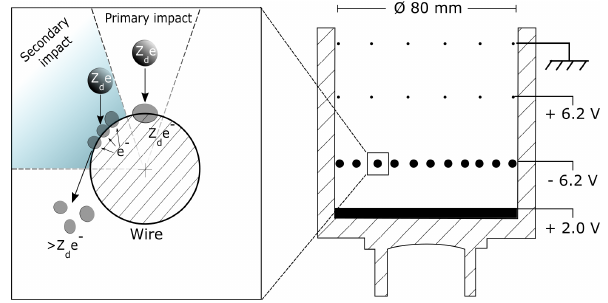
Figure 2. Principle sketch of large, order of 10nm, particles enter- ing DUSTY as launched on the MAXIDUSTY payloads. The mech- anism can be described as follows. (1) A large particle deposits its charge in a primary impact and is partly fragmented. (2) If the im- pact is grazing, fragments can steal electrons from the grid wire. For large particles, the fragments tend to take away more electrons from the wires than the incoming charge and the net current to G2 becomes positive. For small particles, the primary charge is usu- ally larger than the fragment current, and the net current to G2 thus becomes negative. In both cases, the bottom plate current becomes negative. We note that the secondary impact area region is exagger- ated here; the true secondary charge-producing area is (cid:38) 20%.